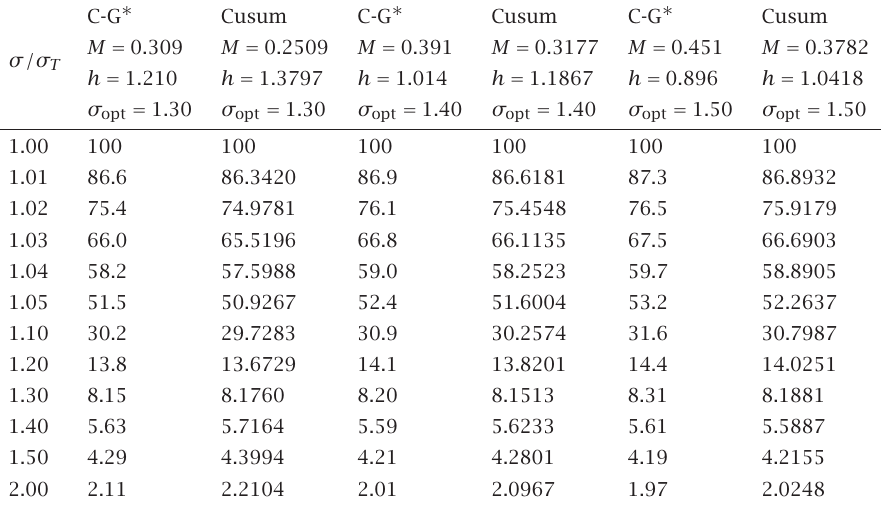
Table 4.3 . Comparisons of the ARL profile of optimal Cusum chart obtained using Regula’s procedure and optimal Cusum designed by Chang and Gan (C-G) when statistic log S 2 , n = 5, and Z 0 = 0 are